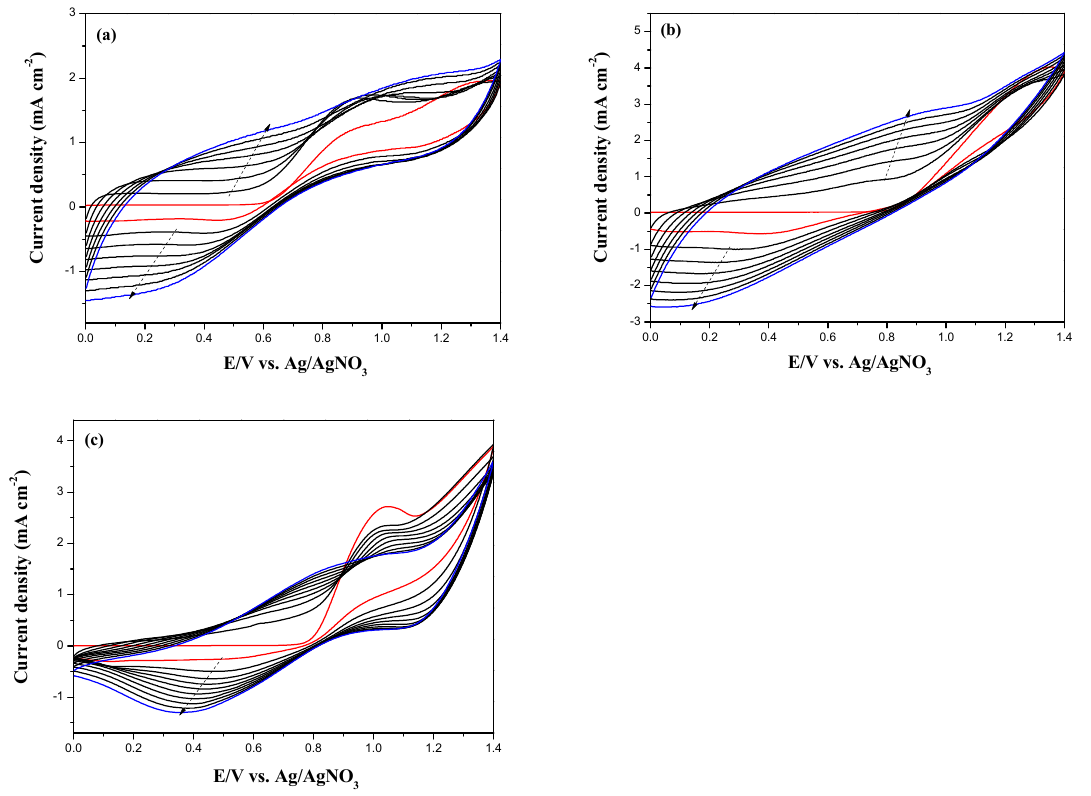
Figure 3. Electrochemical synthesis of ( a ) PInc, ( b ) P(Inc- co -bT), and ( c ) PbT in PC + ACN solution at 100 mV s − 1 on ITO working electrodes.